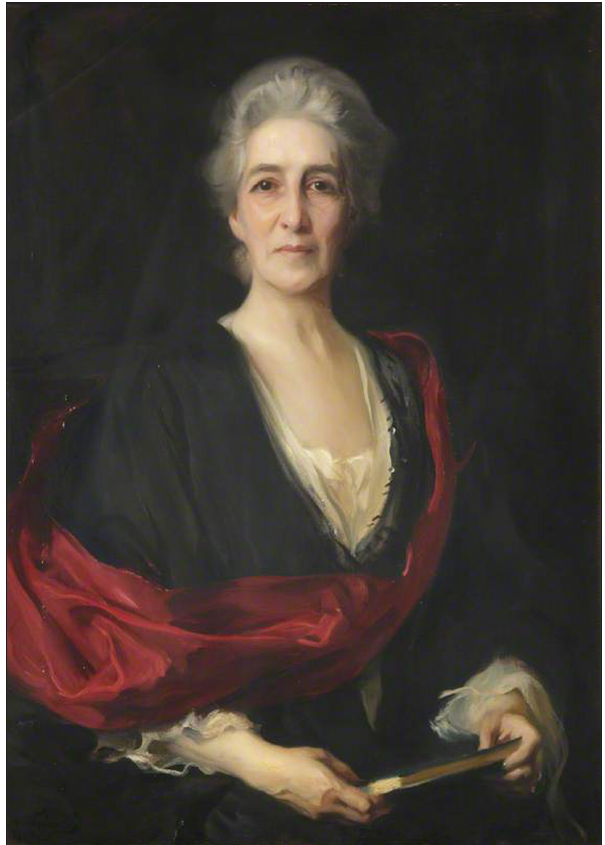
Fig. 9 : Philip Alexius de László, Henrietta Jex-Blake, Principal (1909–1921) , 1921, oil on canvas, 90 × 69.5 cm, Lady Margaret Hall, University of Oxford,